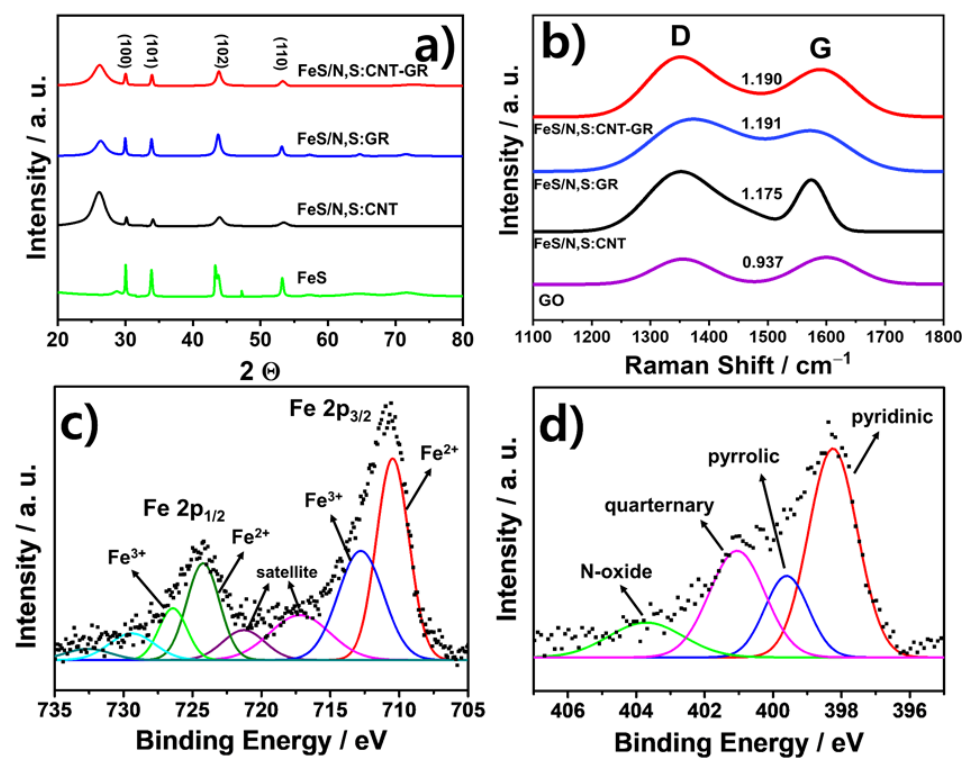
Figure 2. ( a ) XRD patterns of prepared FeS catalysts. ( b ) Raman spectra of graphene oxide (GO) and prepared FeS catalysts. XPS of FeS/N,S:CNT–GR for ( c ) Fe 2p and ( d ) N 1s peaks.